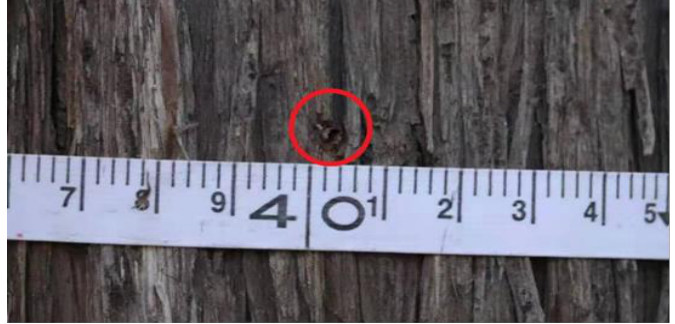
Figure 21. The living wood measurement.